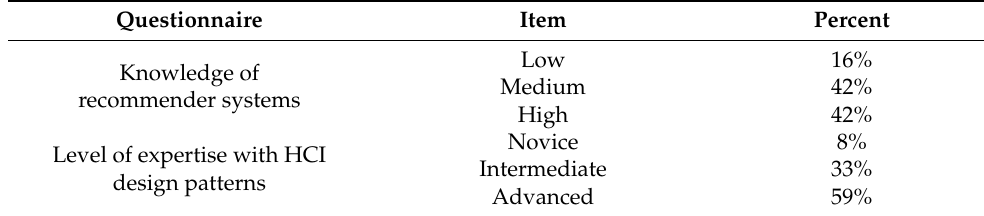
Table 5. Pre-study questionnaire results.